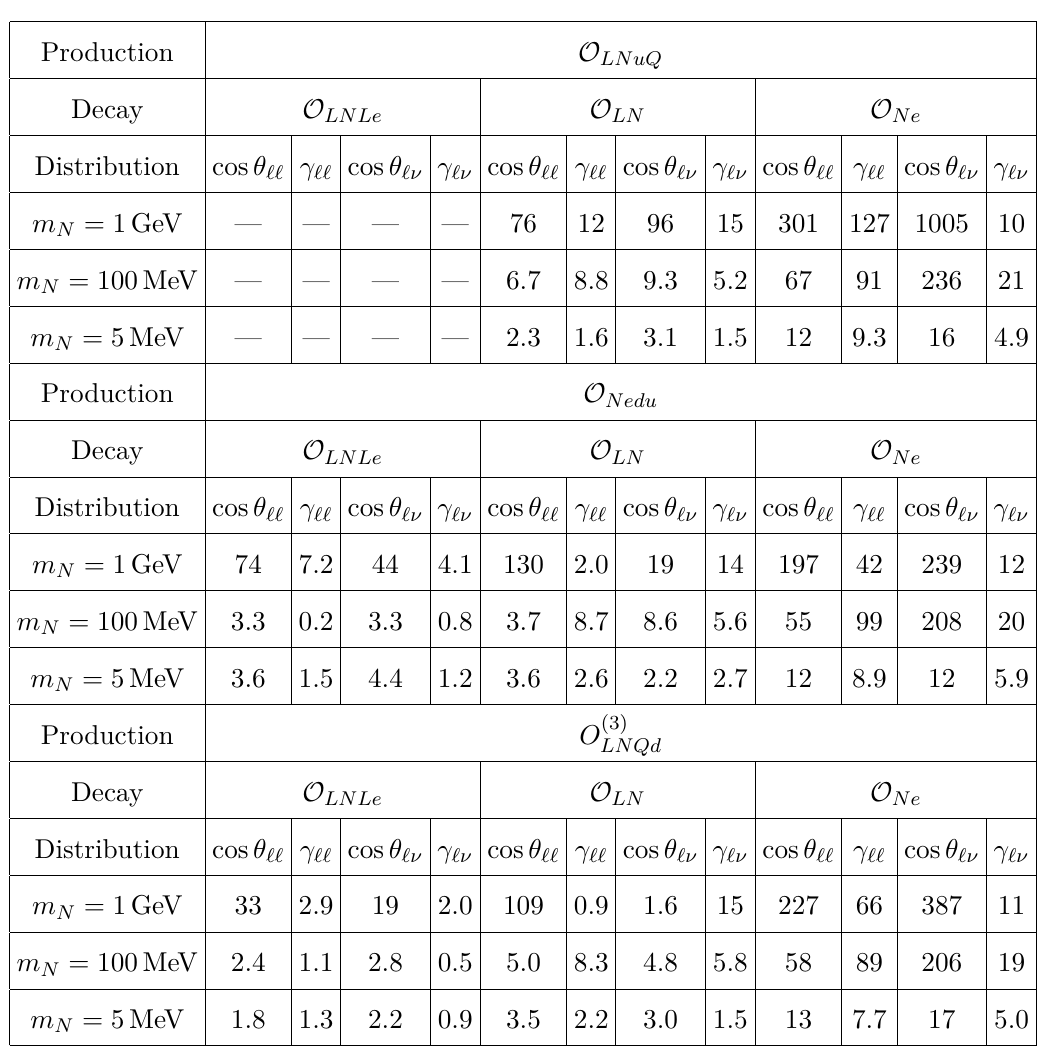
Table 10 . Same as table 9, except for three-body B